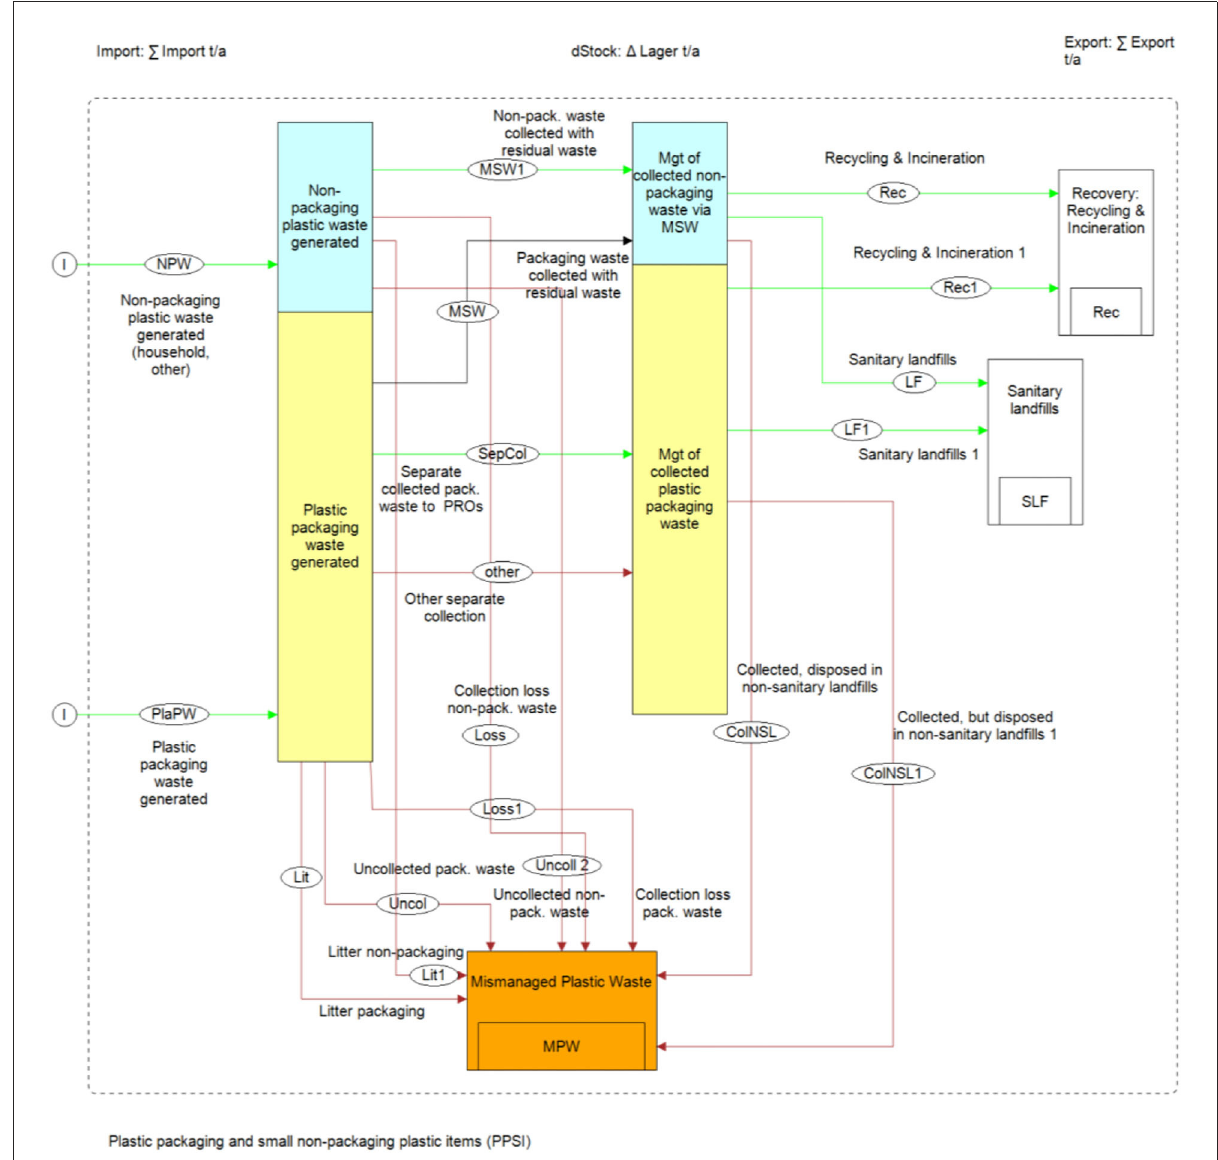
FIGURE1 Conceptual material flow model to quantify mismanaged PPSI waste (STAN software, Cencic and Rechberger, 2008). PPSI, plastic packaging and small non-packaging plastic items.